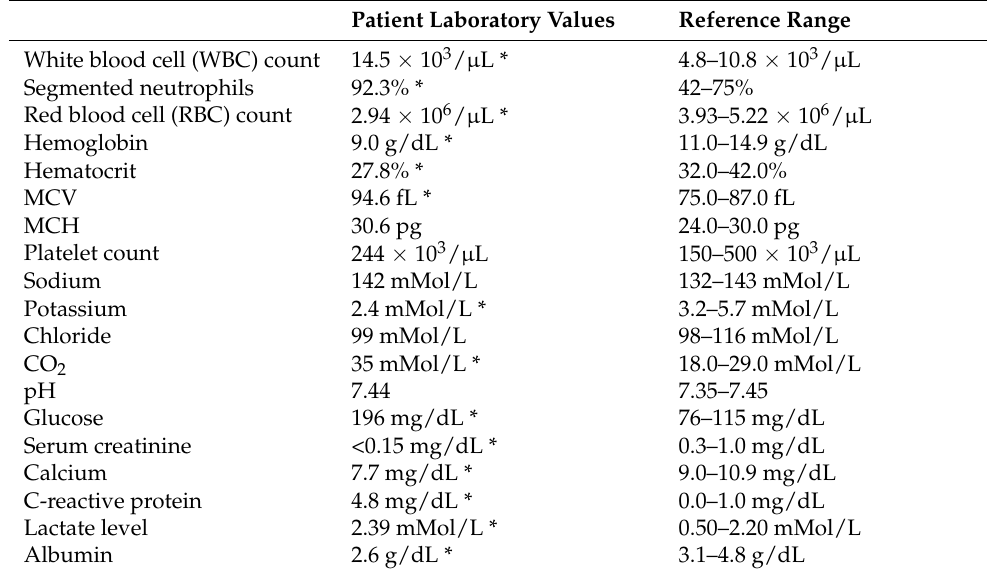
Table 1. Patient’s relevant laboratory results on